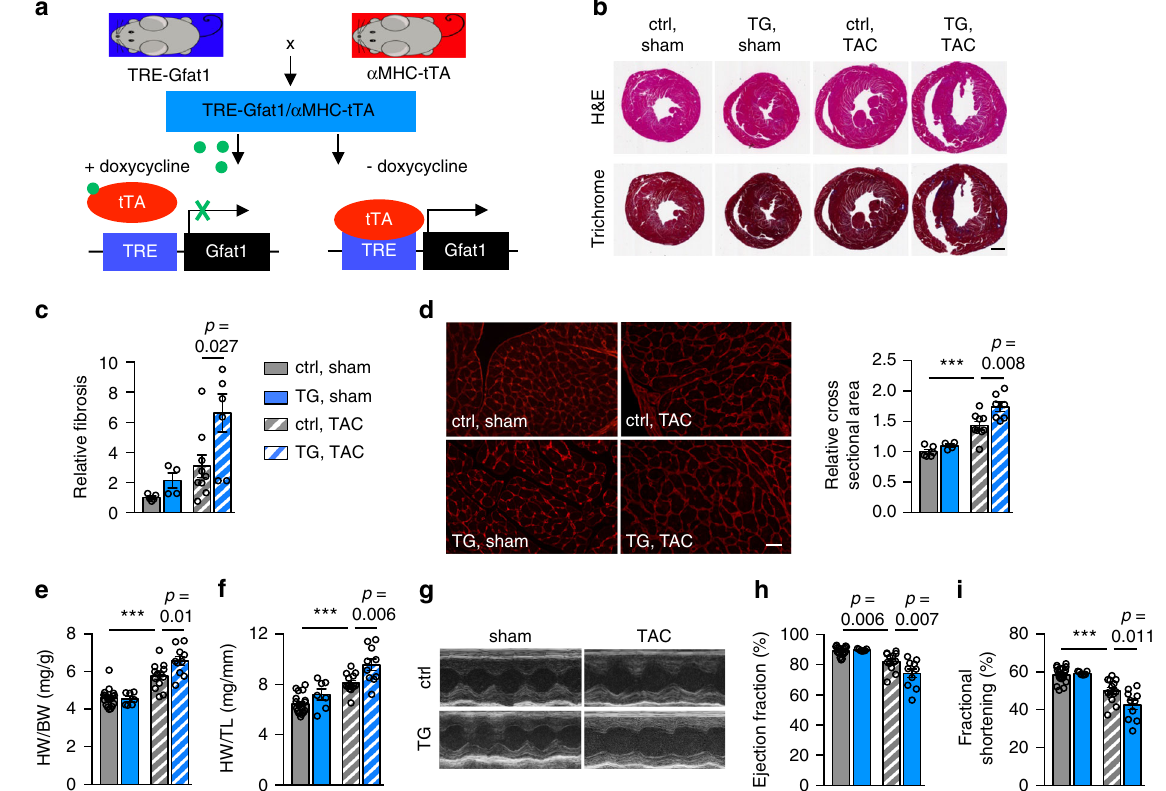
Fig. 5 Cardiac-speci fi c overexpression of Gfat1 leads to a more profound hypertrophic response by pressure overload. a Schematic representation of TRE-Gfat1 and α MHC-tTA models for generation of the cardiac-speci fi c Gfat1 transgenic mouse model (TG). Control (either TRE-Gfat1 only or α MHC-tTA only) and TG (TRE-Gfat1; α MHC-tTA double transgenic) mice were maintained on doxycycline water to suppress the transgene Gfat1 expression. These mice were switched to regular water for 2 weeks to induce Gfat1 expression and then subjected to surgery. b Representative images of mouse heart sections stained with either hematoxylin & eosin or Masson ’ s trichrome at 3 weeks post sham or TAC. Scale: 1 mm. c Quanti fi cation showed a signi fi cant increase of fi brosis in the Gfat1 TG heart after TAC. N = 5 for ctrl/sham; n = 4 for TG/sham; n = 9 for ctrl/TAC; n = 7 for TG/TAC. d Wheat germ agglutinin (WGA) staining of cardiac sections (left) showed a signi fi cant increase in cardiomyocyte size (quanti fi ed at right) in the TG mice after TAC. Scale: 20 μ m. N = 6 for ctrl/sham; n = 4 for TG/sham; n = 9 for ctrl/TAC; n = 7 for TG/TAC. e Measurements of heart weight/body weight ratio (HW/ BW) indicate signi fi cant cardiac hypertrophic growth in the TG mice. f Heart weight/tibia length ratio (HW/TL) suggests that Gfat1 overexpression in the heart led to more profound cardiac hypertrophy by pressure overload. g Representative images of M-mode echocardiography. h Gfat1 overexpression exacerbated cardiac response by pressure overload as shown by a signi fi cant decrease in ejection fraction. i Fractional shortening measurement indicates that Gfat1 overexpression led to cardiac dysfunction after TAC in TG mice compared to control animals. N = 19 for ctrl/sham; n = 7 for TG/sham; n = 13 for ctrl/TAC; n = 10 for TG/TAC ( e – i ). Data are shown as mean ± SEM. Signi fi cance was calculated by two-way ANOVA, followed by Tukey ’ s test. *** p < 0.001. Source data are provided as a Source Data fi